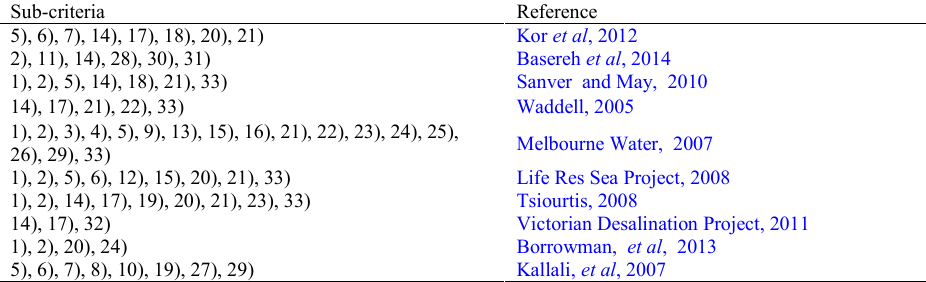
Fig. 2: Flowchart of different steps of site selection for desalination plants Table 1: Identifying effective factors in different studies